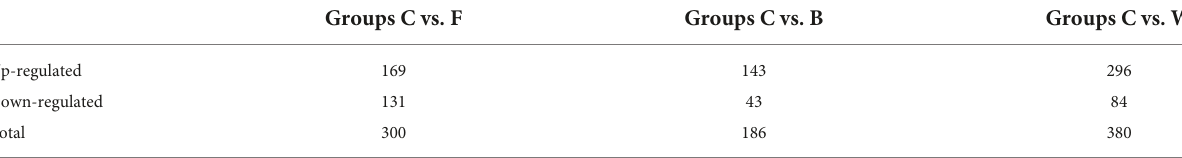
TABLE 7 Differentially expressed genes (DEGs) identified in three pairwise comparisons between the control (group C) and each of the three experiments groups of Landes geese (i.e., groups F, B, and W) treated with brewers’ spent grain (BSG) on day 90 based on transcriptomics analysis. Groups C vs.